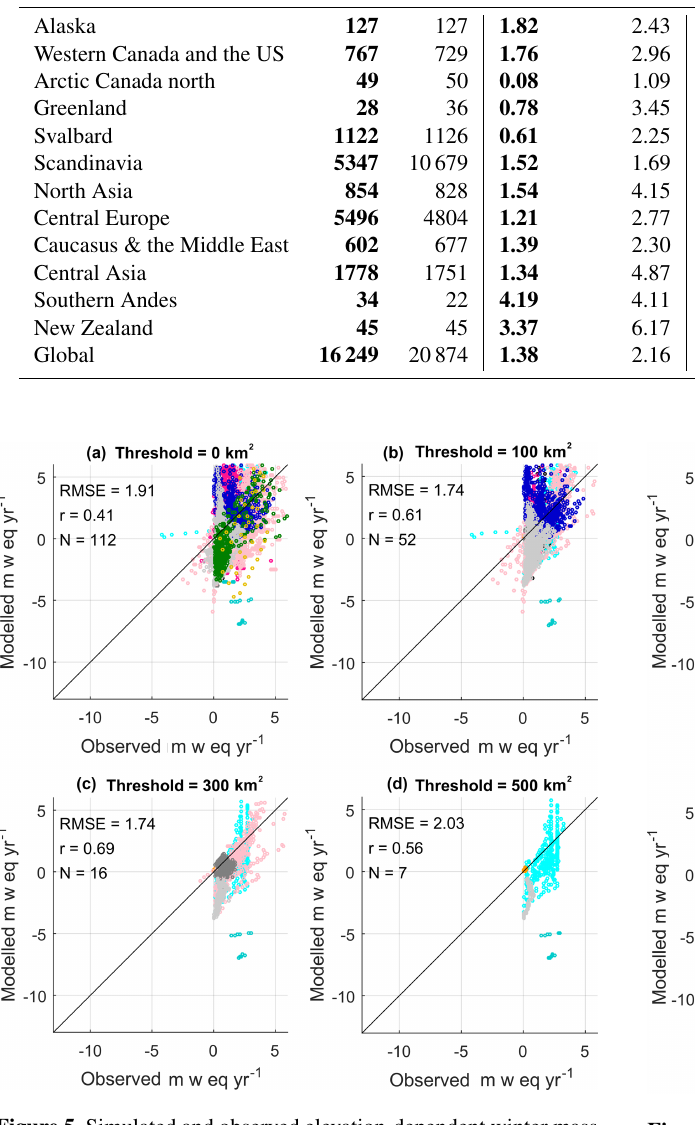
Figure 6. Simulated and observed elevation-dependent summer mass balance when grid boxes with a glacier area of less than 100, 300, and 500km 2 are excluded. The colour identifies the RGI6 re- gions shown in Fig. 2. The RMSE, correlation coefficient, and num- ber of glaciers are